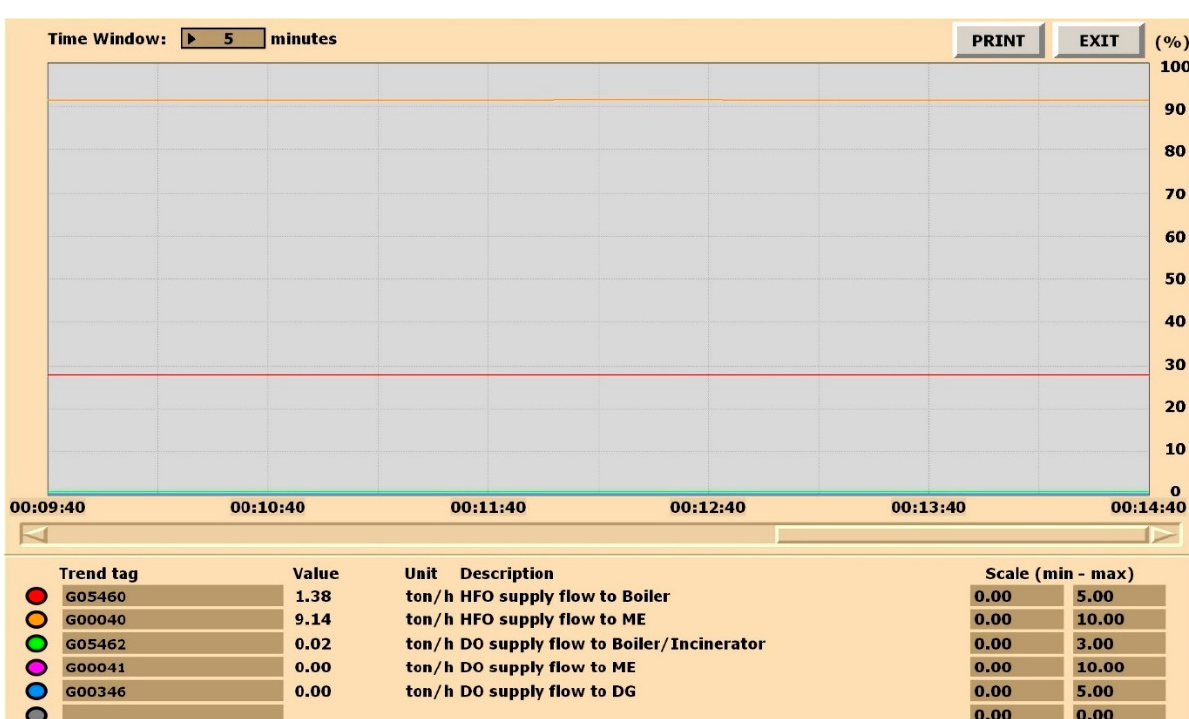
Figure 5. Fuel flows for mode 2.1 (container ship).